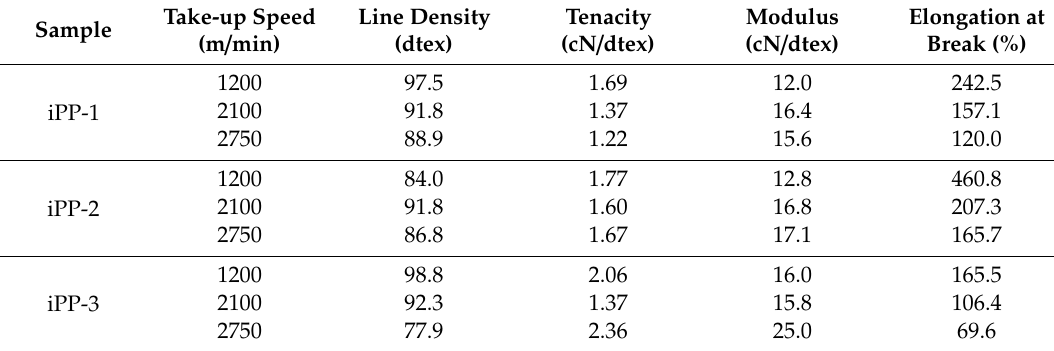
Table 6. Tensile properties of as-spun iPP